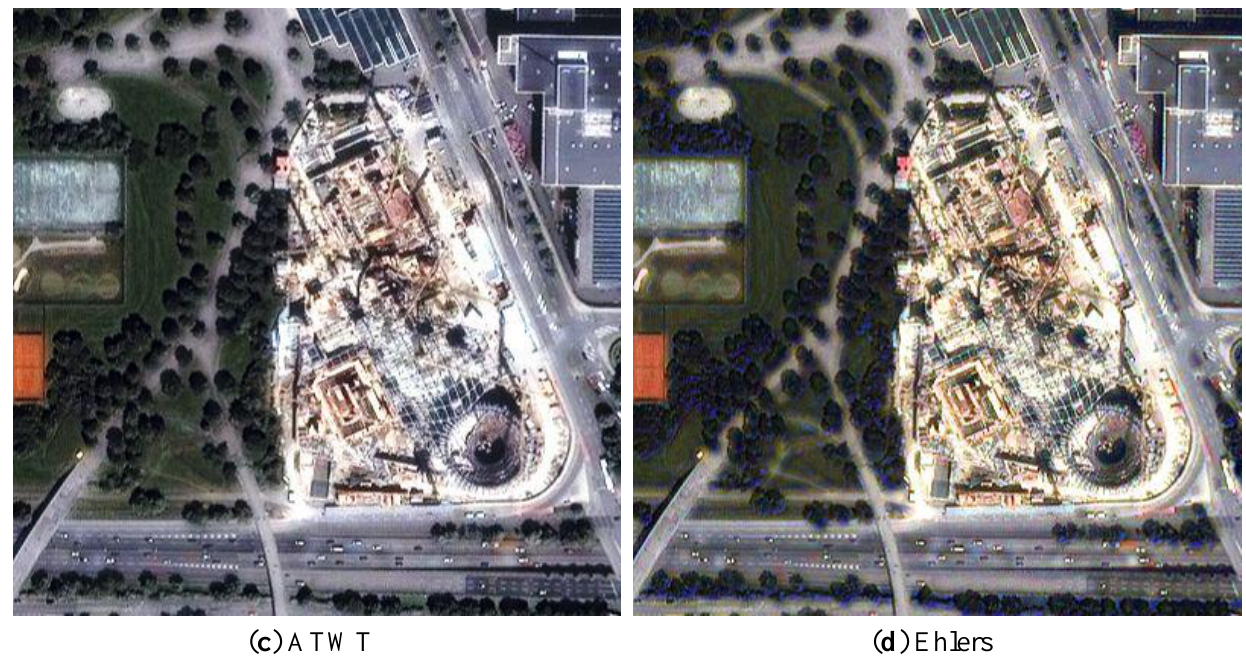
Figure 12. Different fusion methods: CS IHS ( a ), CS GS ( b ), ATWT ( c ) and Ehlers ( d ) for IKONOS